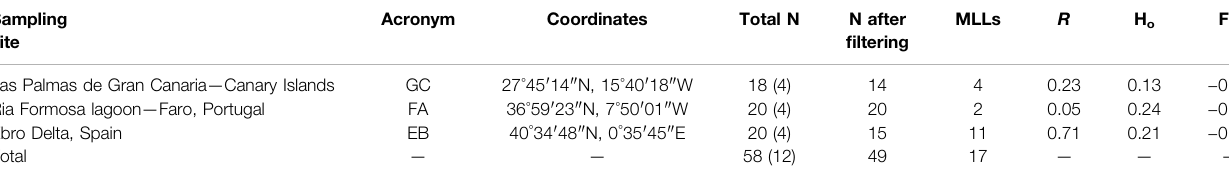
TABLE 1 | Information on sampling sites, sample details and genetic indices obtained with 2b-RAD genotyping. For each population, the following information are shown: acronym, geographic coordinates (latitude and longitude), number of sequenced individuals N and number of additional technical replicates in parenthesis, number of individuals retained after fi ltering procedures and removal of technical replicates, total number of distinct Multi Locus Lineages (MLLs), R value (G-1/N-1), observed heterozygosity (H o ) and inbreeding coef fi cient (F IS